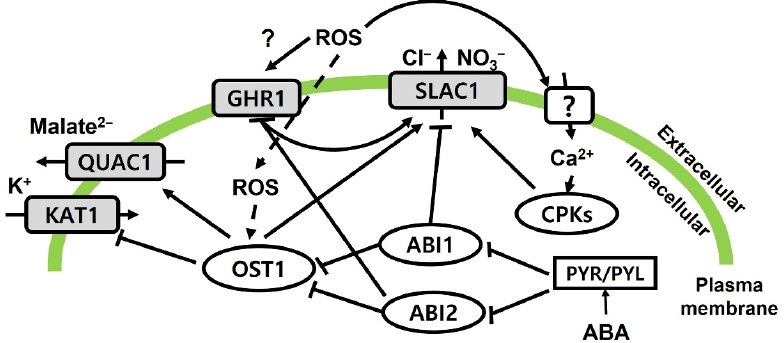
Figure 6. Diagram showing the regulation of guard cell ion channels in response to ozone. ABA: abscisic acid; ABI1: ABA-insensitive 1; ABI2: ABA-insensitive 2; CPKs: calcium-dependent protein kinases; GHR1: guard cell hydrogen peroxide-resistant 1; KAT1: inward rectifying K+ channel; OST1: open stomata 1; PYR/PYL: pyrabactin resistance/PYR-like; QUAC1: quickly activating anion channel. Figure from [47].